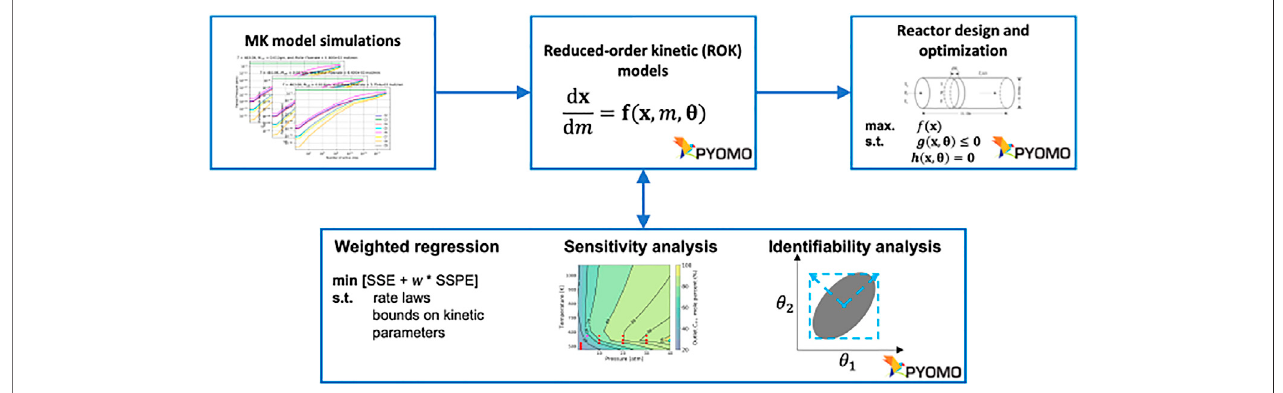
FIGURE 1 | Proposed multiscale modeling framework for oligomerization reactor modeling and design optimization.